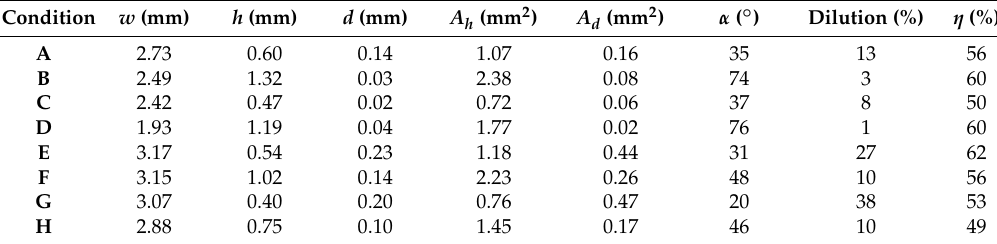
Table 5. Average geometrical responses in the cross section for deposition over a flat surface. Condition